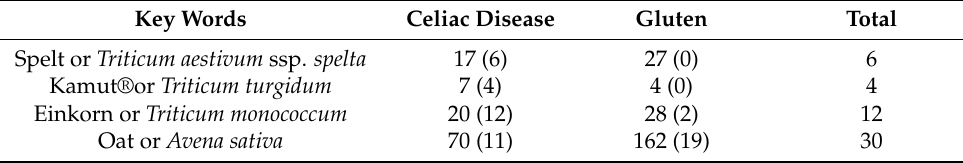
Table 3. Studies collected from database searches. Those selected are in brackets. Celiac